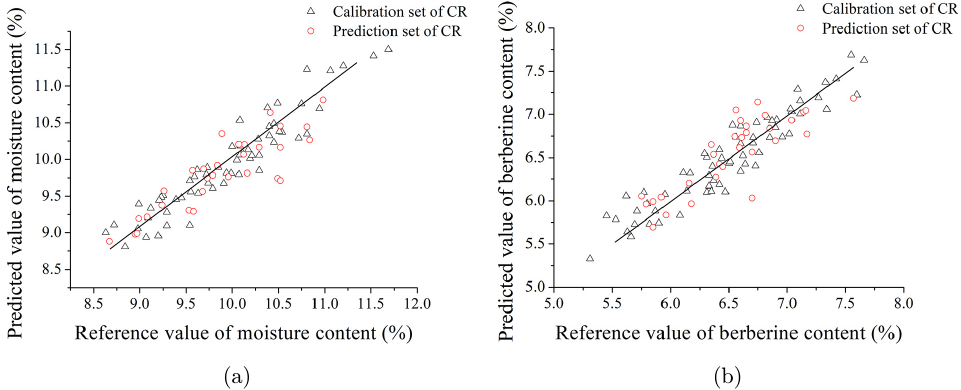
Fig. 8. Correlation diagram between NIRS predicted values and reference values of CR model. (a) Moisture content and (b) Berberine